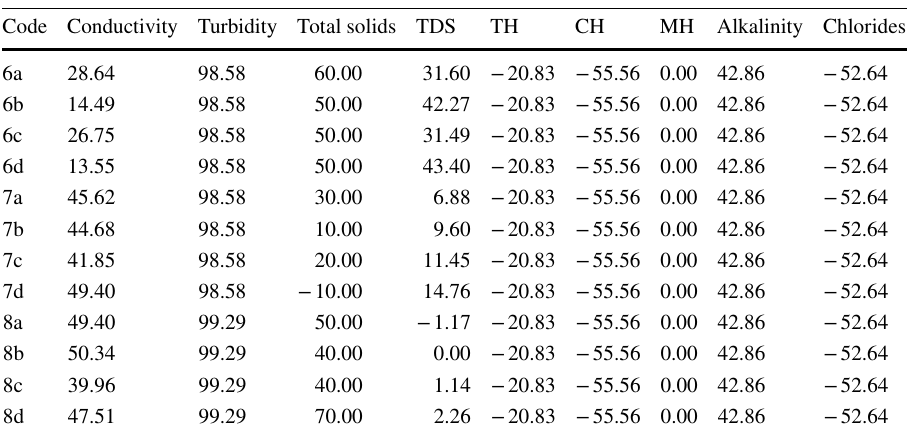
TDS total dissolved solids, TH total hardness, MH